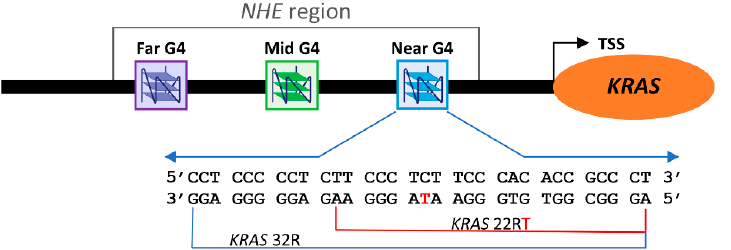
Figure 1. Schematic representation of the Nuclease-Hypersensitive Element (NHE) region of the KRAS gene promoter.